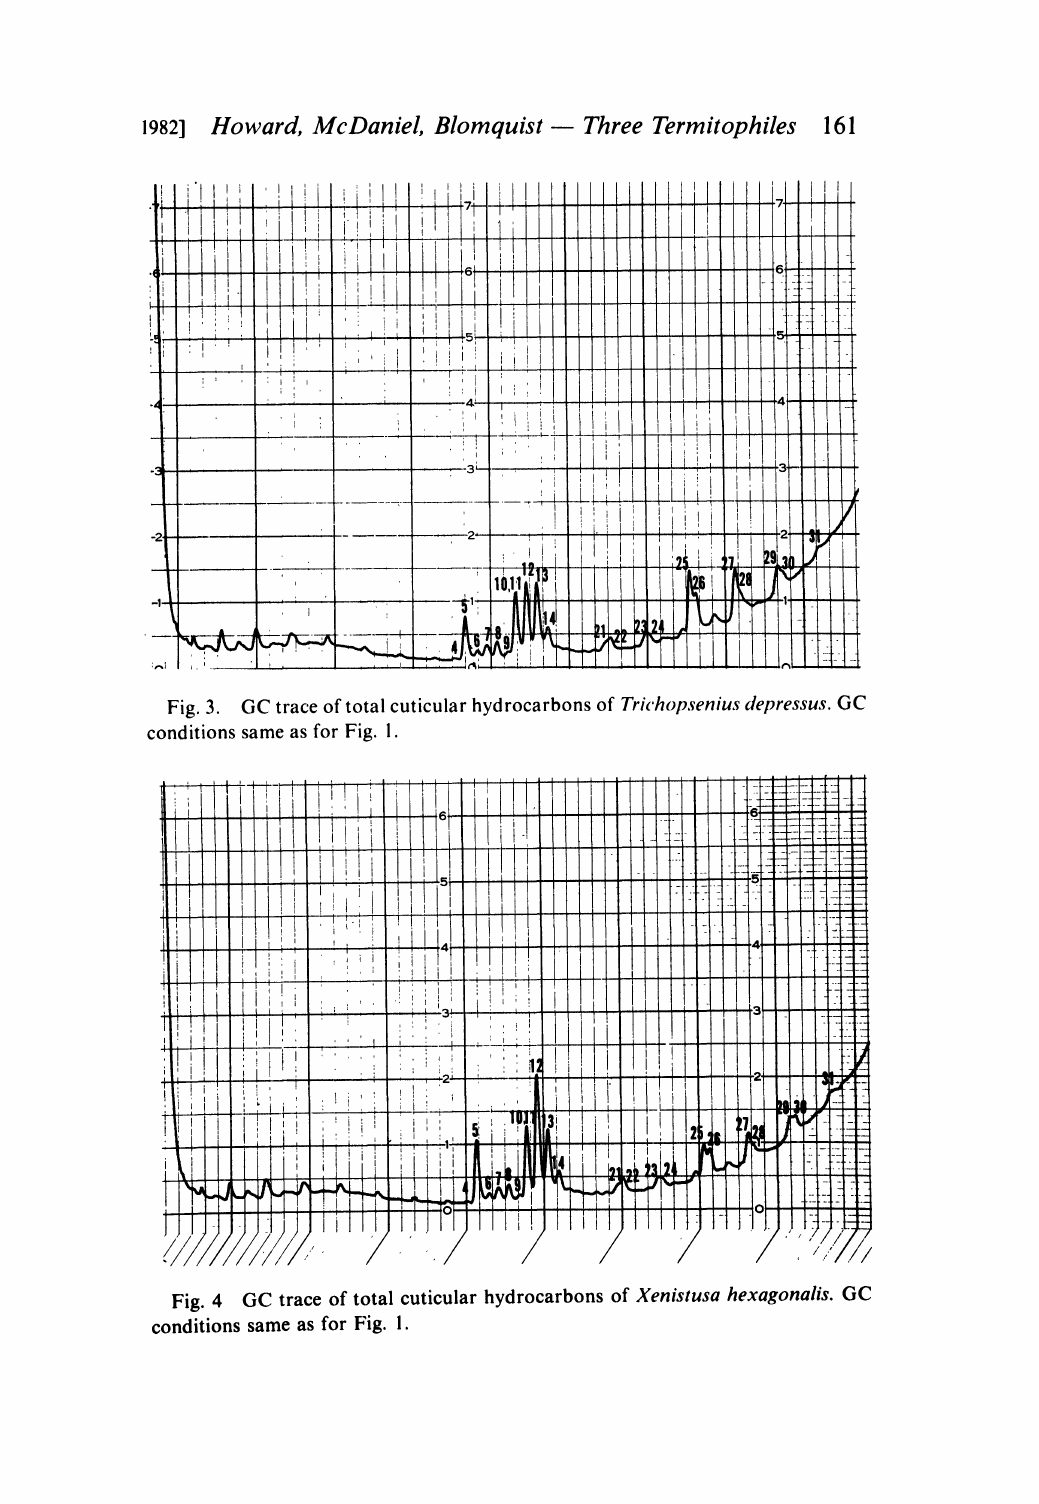
Fig. 3. GC trace of total cuticular hydrocarbons of Trichopsenius depressus. GC conditions same as for Fig. 1.